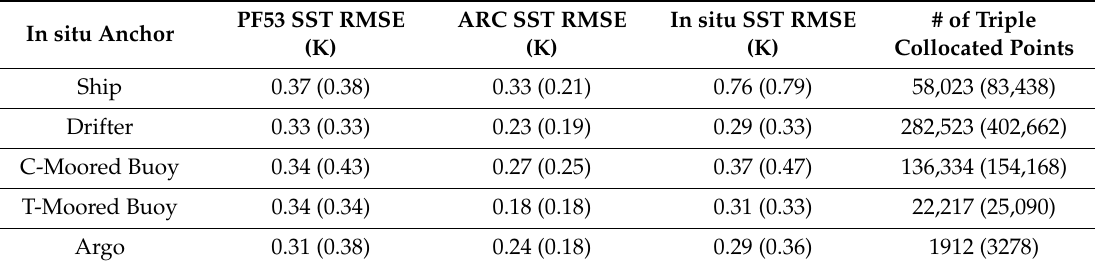
Figure 3. ( a – e ): Nighttime root-mean-square-errors (RMSEs) of ARC, PF53, and in situ data derived from the triple collocation between the three datasets; ( f ): time series of the number of triple collocated matchups for each standard transfer. Table 2. Nighttime RMSE for the three datasets using the ETC three-way error analysis, with the corresponding daytime values in the